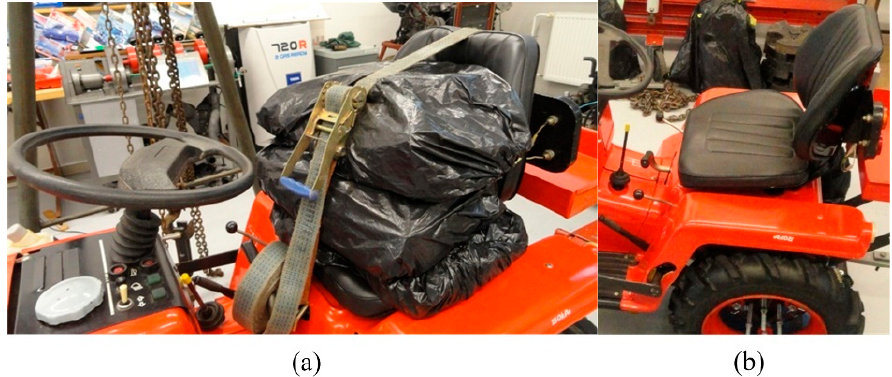
Figure 4. Simulation of tractor driver: ( a ) Three sandbags on the driver seat; ( b ) Empty seat. The calculation methods for static overturning angle were compared at three overall tire widths (low, medium, and high), as listed in Table 1. Experiments were performed with the tractors equipped with two levels of rear wheel ballast weights and with no ballast weight. The subcompact tractor allows the setting of 30.5 kg or 61 kg of rear ballast weight considering a single steel disc weight of 15.25 kg. The universal tractor was loaded with 180 kg using two single adapters for connections of steel discs. The second load level of 300 kg was achieved using the adapters with two steel discs. The weight of the single adapter was 90 kg, and the weight of the single steel disc was 60